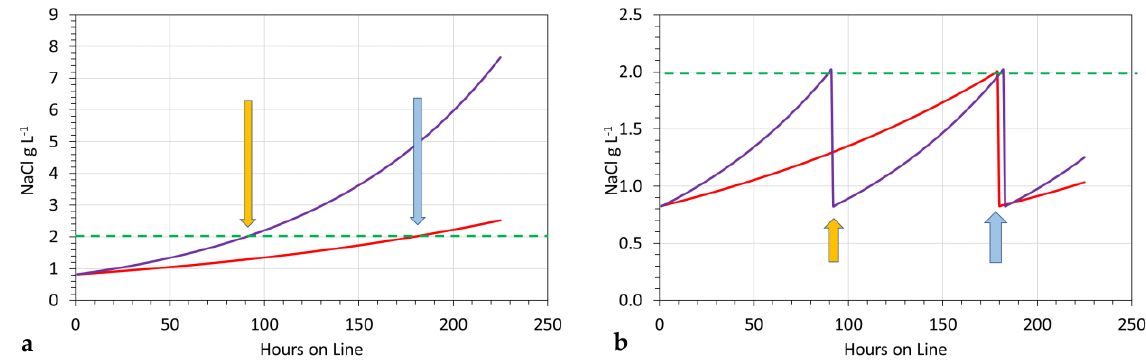
Figure 19. Fe@Ca@urea polymer: Flowback water analysis. R r = 0%; P w = 5.6 g FeSO 4 L −1 + 13.36 g CaO L −1 + 5.28 g urea L −1 ; ( a ) product water NaCl g L −1 versus time without polymer replacement. [d] = 1.005: red; [d] = 1.01: purple; green dashed line = maximum acceptable salinity; orange arrow = point at which the polymer needs to be replaced or recharged for [ d ] = 1.01; blue arrow = point at which the polymer needs to be replaced or recharged for [ d ] = 1.005; ( b ) product water NaCl g L −1 versus time with periodic polymer replacement. Feed water contains 12.3 g L −1 ; Water duration in the reaction environment = 1 h.